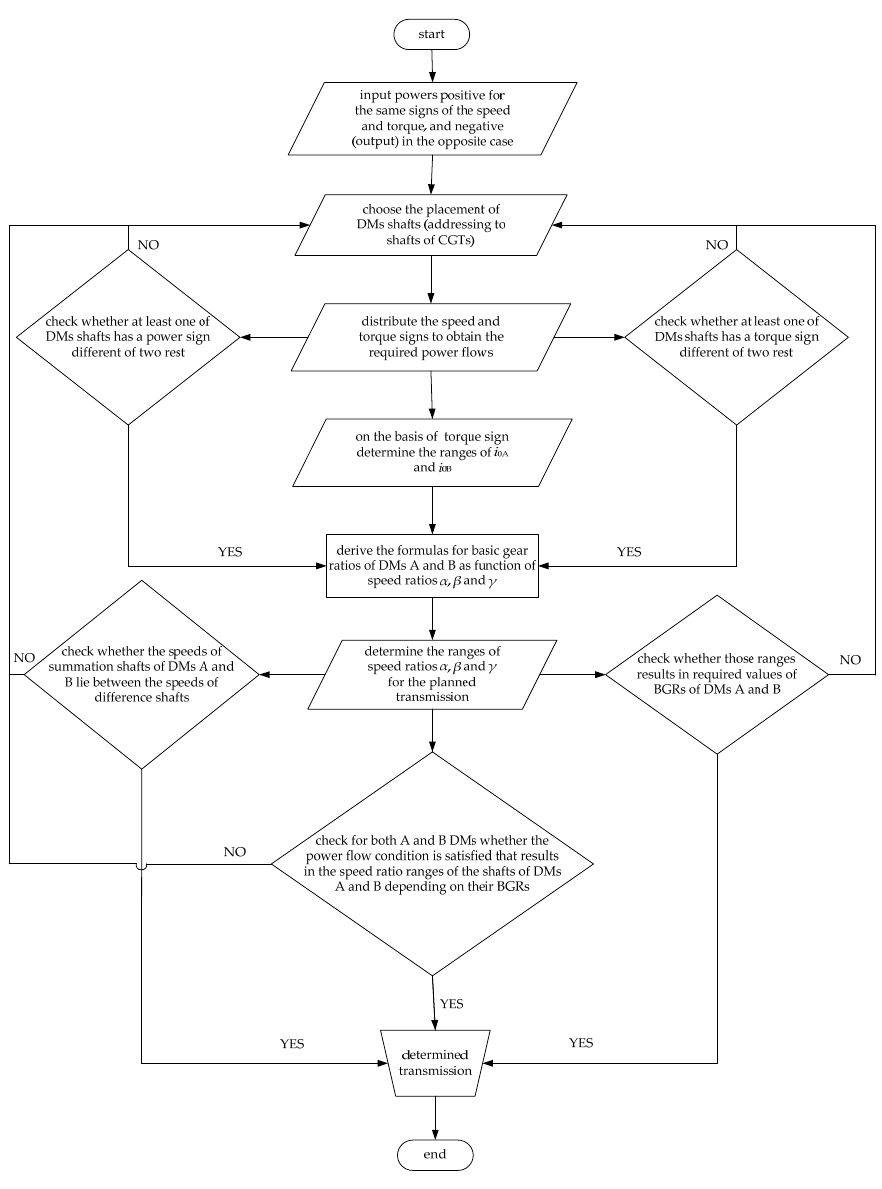
Figure 4. The block diagram for transmission design procedure.